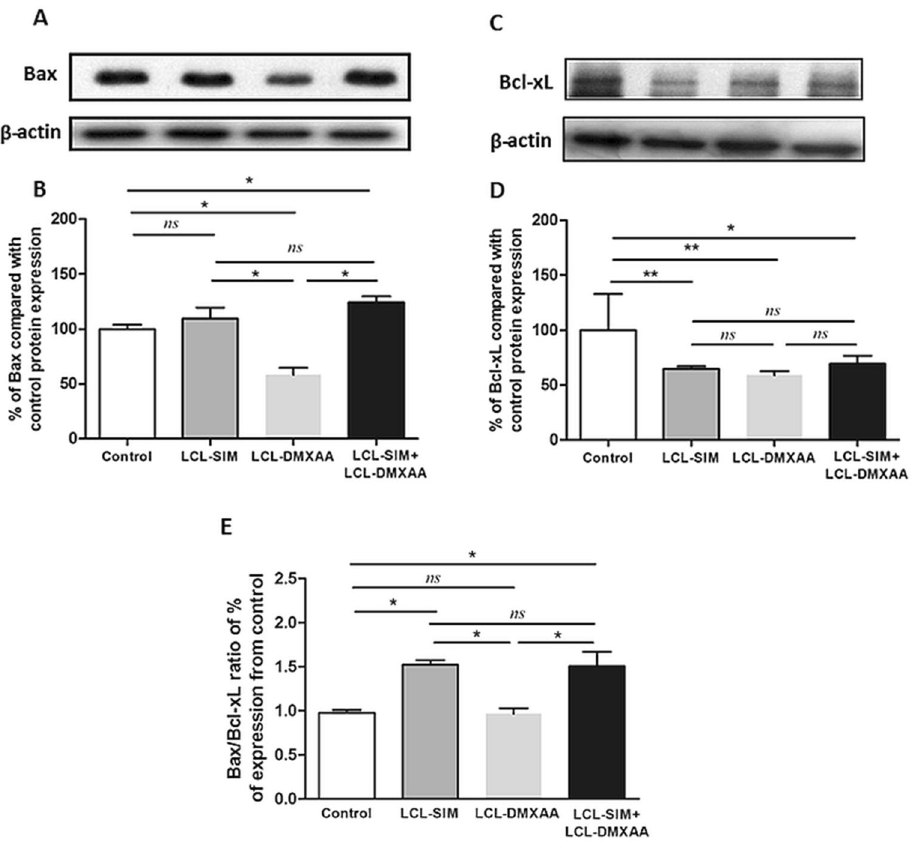
Figure 4. Effects of liposome-encapsulated SIM and DMXAA on intratumoral levels of apoptotic proteins. ( A ), ( B ) Western blot analysis showing the effects of different treatments on the intratumor levels of Bax and Bcl-xL, respectively. β-actin was used as loading control. ( C ), ( D ) Protein levels of Bax and Bcl-xL in lysates from treated groups expressed as percentage from control—LCL-treated group. ( E ) The ratio of % expression levels of Bax/Bcl-xL compared to Control. Data represent the mean ± SD of two independent measurements. One way ANOVA test with Bonferroni correction for multiple comparisons was performed to analyze the differences between the effects of the treatments on the apoptotic proteins ( ns , P > 0.05; *, P < 0.05; **, P < 0.01). Control—LCL-treated group; LCL-SIM—experimental group treated with 5 mg/kg SIM as liposome-encapsulated form; LCL-DMXAA—experimental group treated with 14 mg/kg DMXAA as liposome- encapsulated form; LCL-SIM + LCL-DMXAA—experimental group treated with 5 mg/kg SIM and 14 mg/kg DMXAA as liposome-encapsulated forms. The uncropped images of Bax, Bcl-xL and β-actin blots are presented in Supplementary Information file. The graphs were generated using GraphPad Prism 9.2.0.332 (Serial number: figure assembly was generated using Microsoft® Office Home and Student 2019 MSO 64-bit (product ID: 00405- 57743-39916-AA493) (https:// www. micro soft.